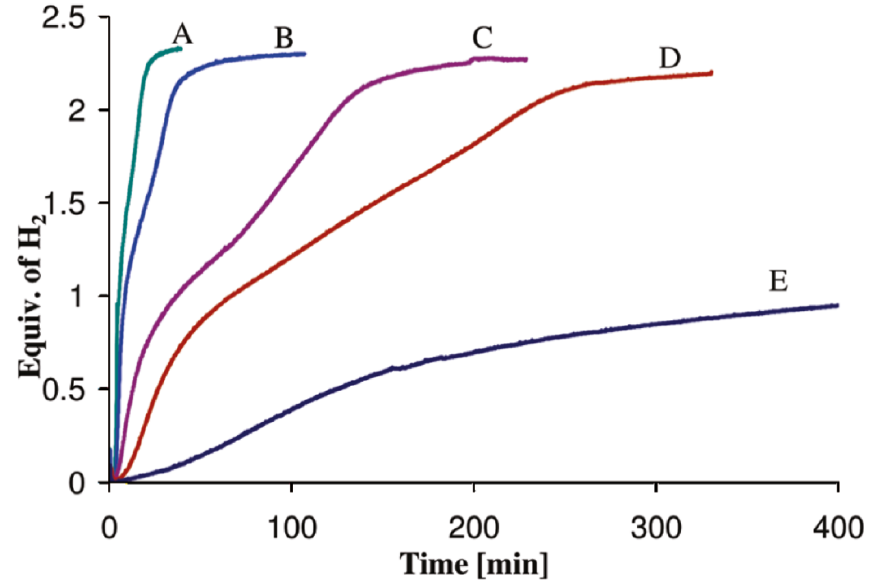
Figure 7. Hydrogen release measurements via gas burret for a 50:50 mixture of AB (150 mg):BmimCl mixture as a function of isothermal temperatures: ( A ) 110 °C, ( B ) 105 °C, ( C ) 95 °C, ( D ) 85 °C, and ( E ) 75 °C; data reproduced from [22].